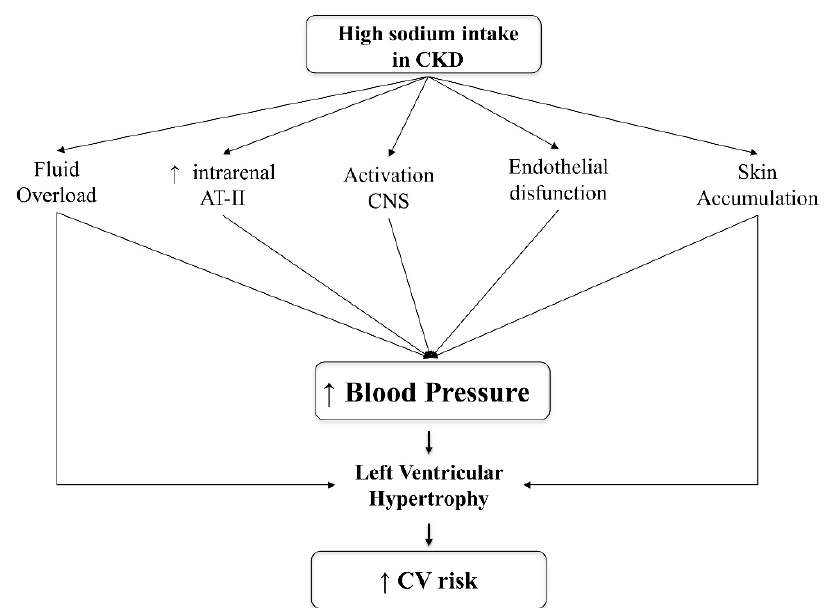
Figure 1. Potential pathogenic mechanisms of hypertension in CKD due to high salt